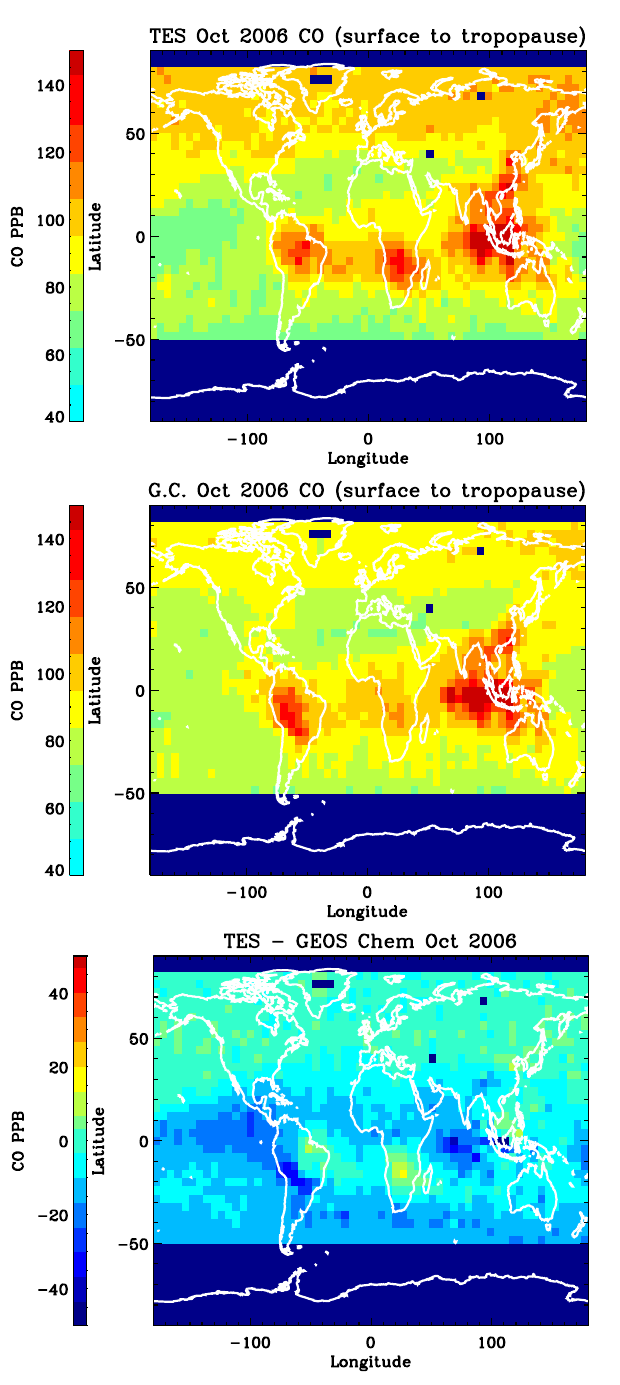
Fig. 7. (a) TES tropospheric CO estimates. (b) Corresponding GEOS-Chem CO estimates adjusted with the TES instrument op- erator. The GEOS-Chem values have been reduced by 19.9ppb. (c) Difference between TES and GEOS-chem.